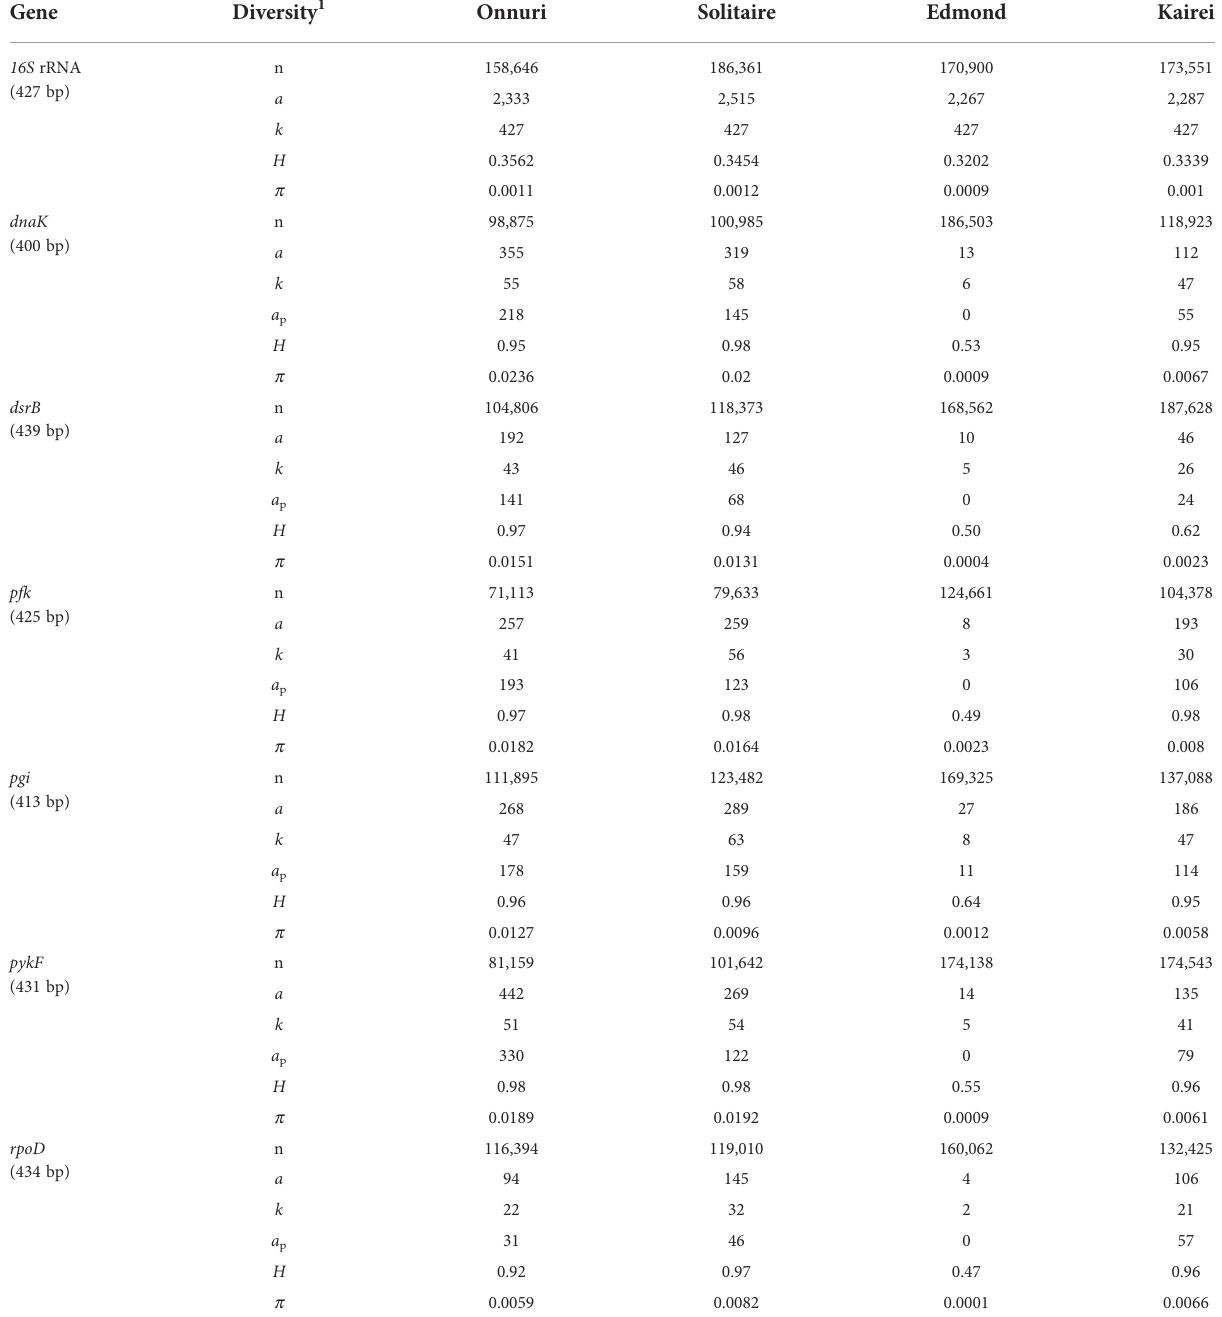
TABLE 2 Genetic diversity indices of symbiont populations on the CIR.